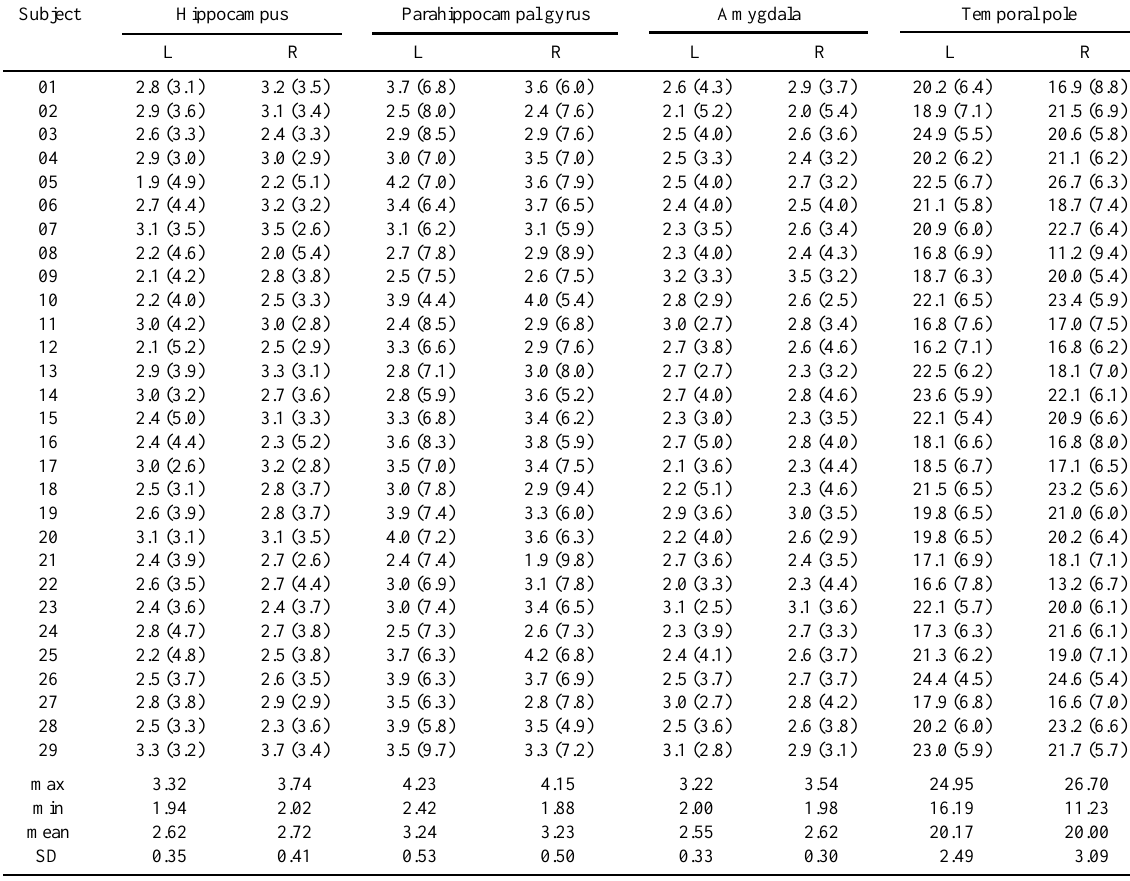
Table 1 Estimated volumes (ml) of the hippocampus, parahippocampal gyrus, amygdala, temporal pole, temporal lobe, lateral ventricles, and caudate nucleus in the left and right cerebral hemispheres together with hemisphere volume for the 29 male subjects